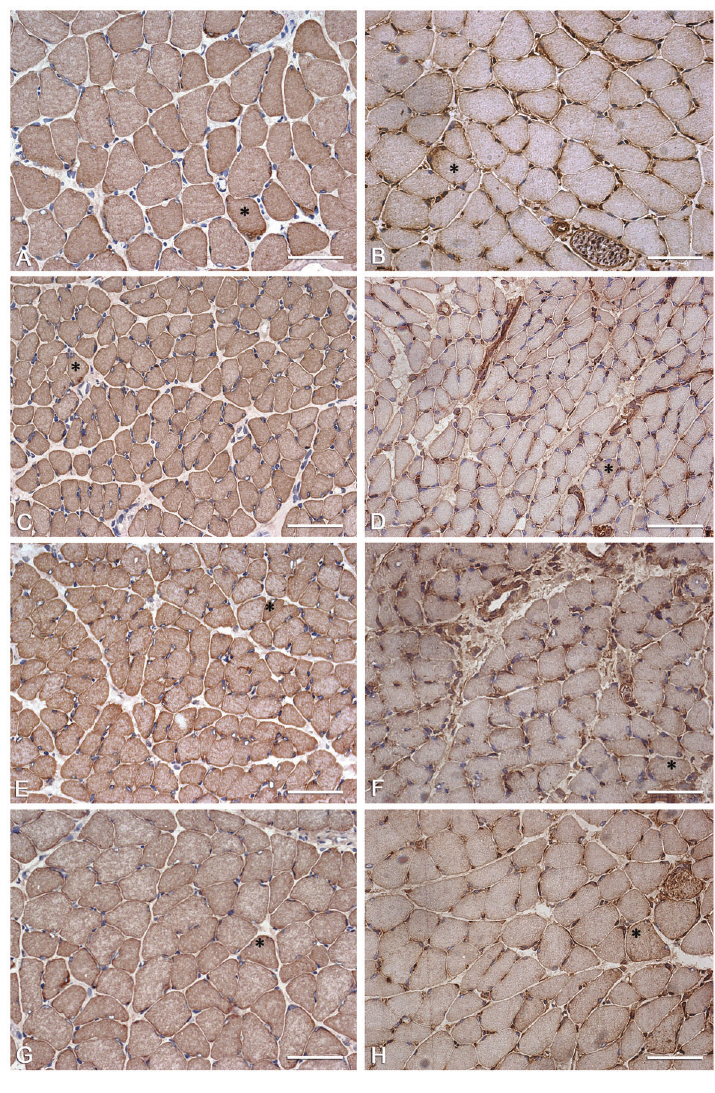
Table 2. Semi-quantitative grading of the picrosirius red staining and speci fi c staining for collagen types I, III, and IV.